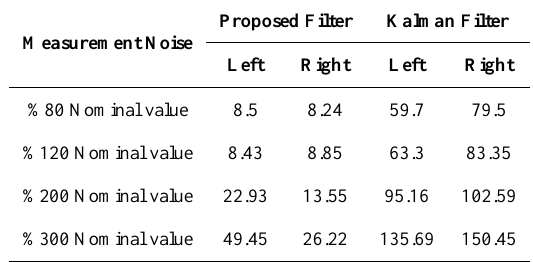
Table 2. Consideration of proposed filter in the second